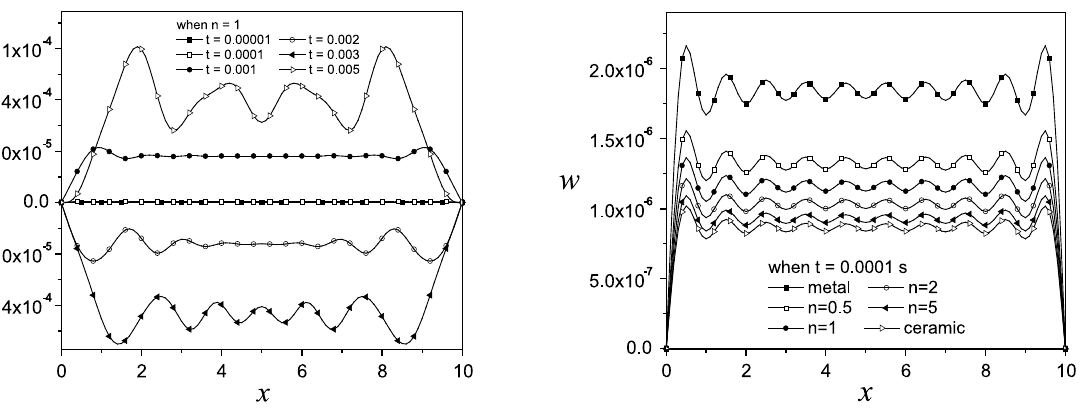
Fig. 14. Deflection of the mid-plane for the simply supported FGPM cylindrical shell imposed by a uniform mechanical load, when n = 1 .